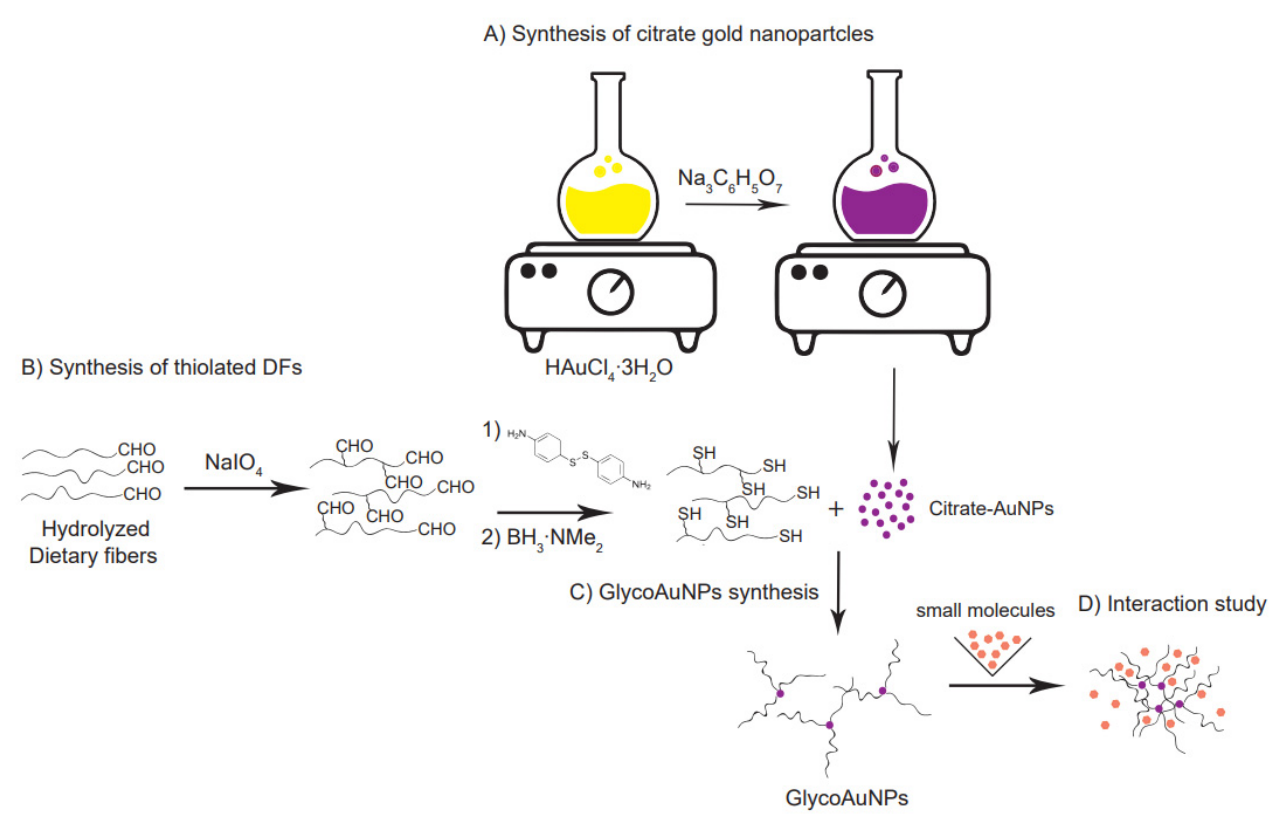
Figure 1. Multi-step synthetic strategy for glyconanoparticle formation. ( A ) Synthesis of citrate-capped gold nanoparticles starting from HAuCl 4 solution. ( B ) Thiolation by reductive amination of the partially hydrolyzed, by NaIO 4 to a low degree oxidized neutral soluble dietary fibers. ( C ) Thiolated fiber conjugation by self-assembly onto the gold nanoparticle surface. ( D ) Molecules triggered aggregation of GlycoAuNPs indicating an interaction.